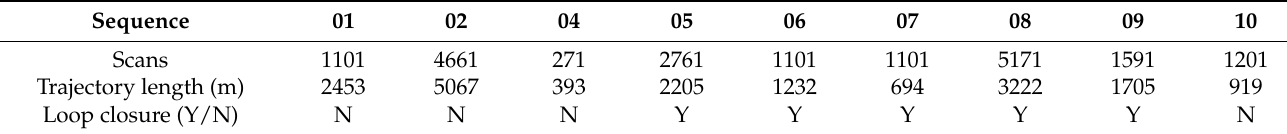
Table 1. Details of the KITTI dataset.